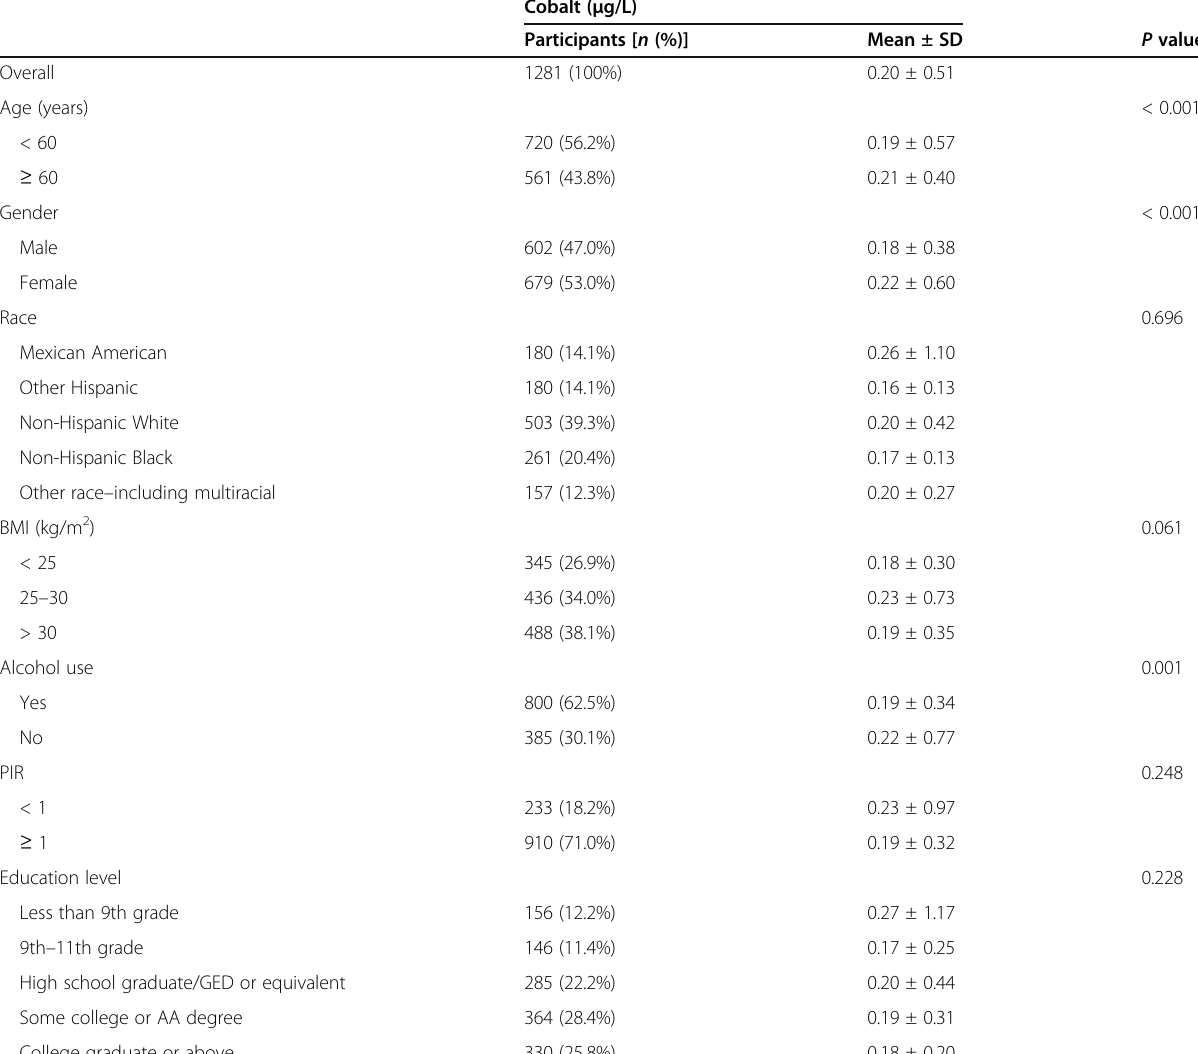
Table 1 Blood cobalt concentration (mean ± SD) according to demographics and lifestyle